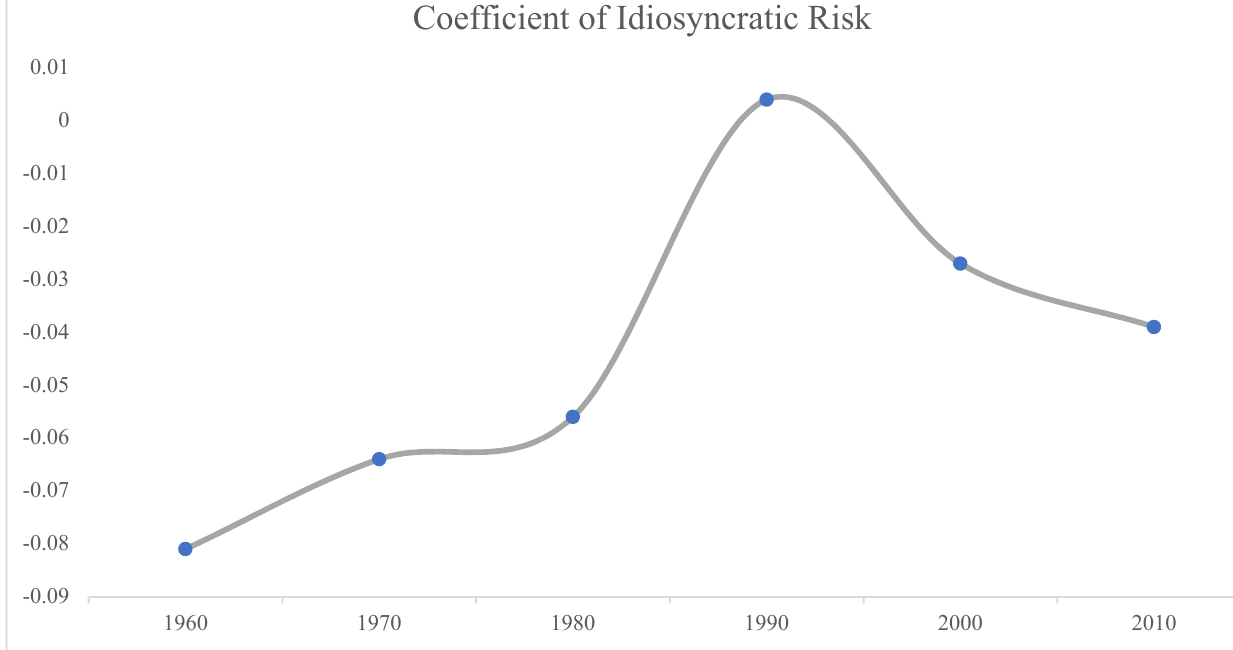
Figure 3. Historical trend in the relation between idiosyncratic risk and stock return. This figure shows the historical patten of regression coefficient of idiosyncratic risk. The regression is discussed in Equation (4). Detailed results of the regression can be found in Table 5.